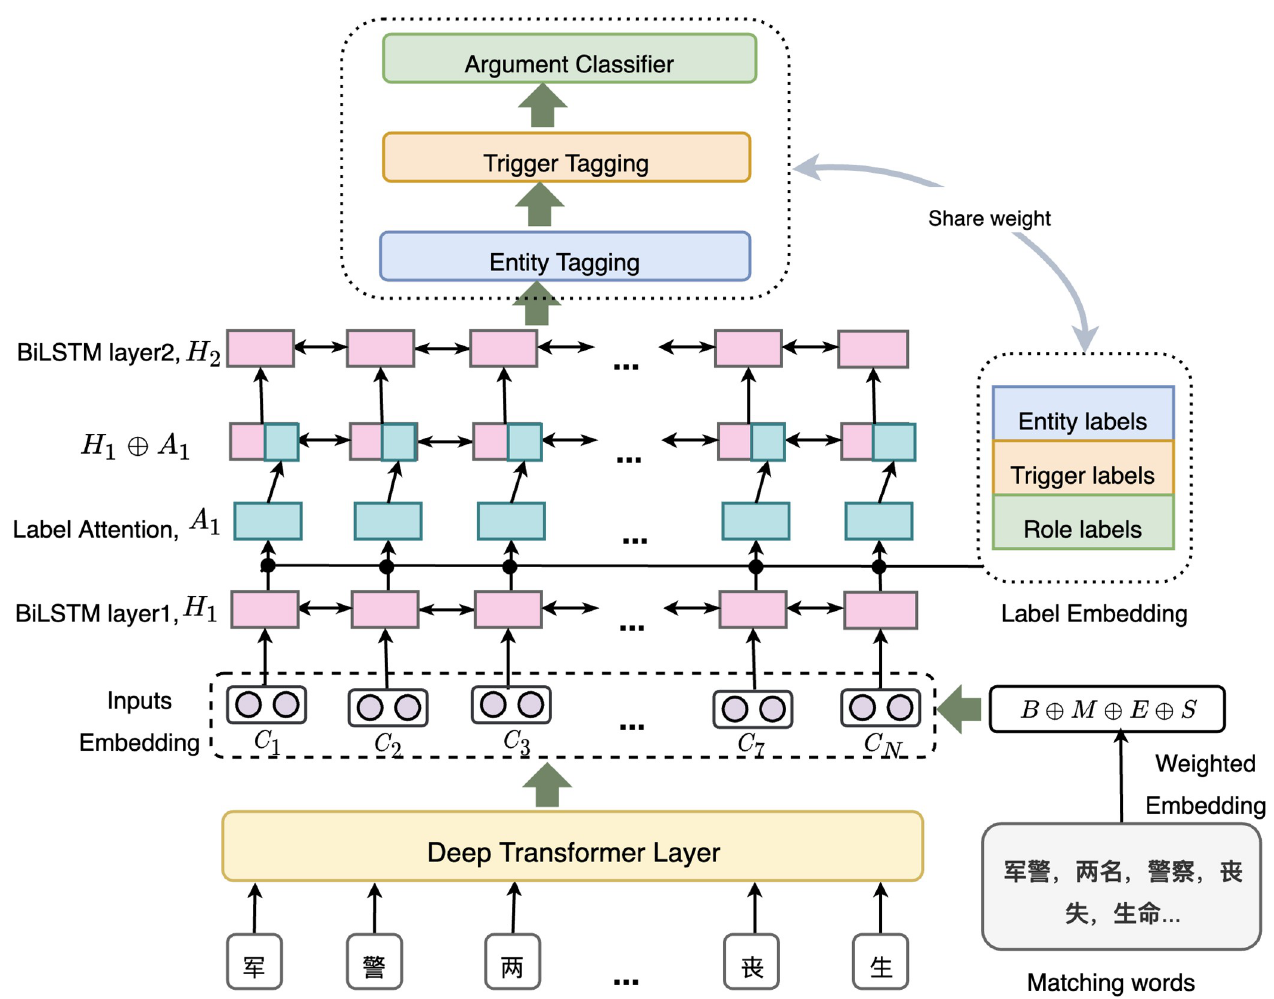
Fig 2. Illustration of our multi-task framework for Chinese event extraction model.